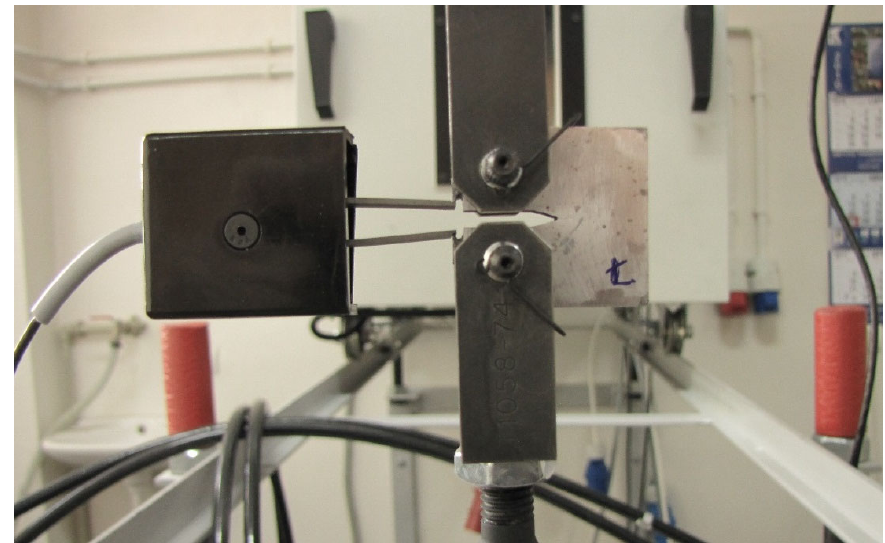
Figure 2. CT mini-specimen made of the 44200 aluminium alloy with the Al 2 O 3 reinforcement and Figure 2. CT mini ‐ specimen made of the 44200 aluminium alloy with the Al 2 O 3 reinforcement and CTOD Instron extensometer with the gripping system of the 8802 Instron servo-hydraulic testing CTOD Instron extensometer with the gripping system of the 8802 Instron servo ‐ hydraulic testing machine.